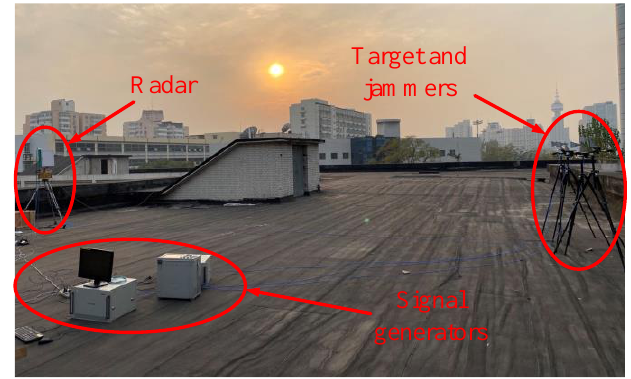
Figure 14. experimental scenario. Figure 14. Experimental